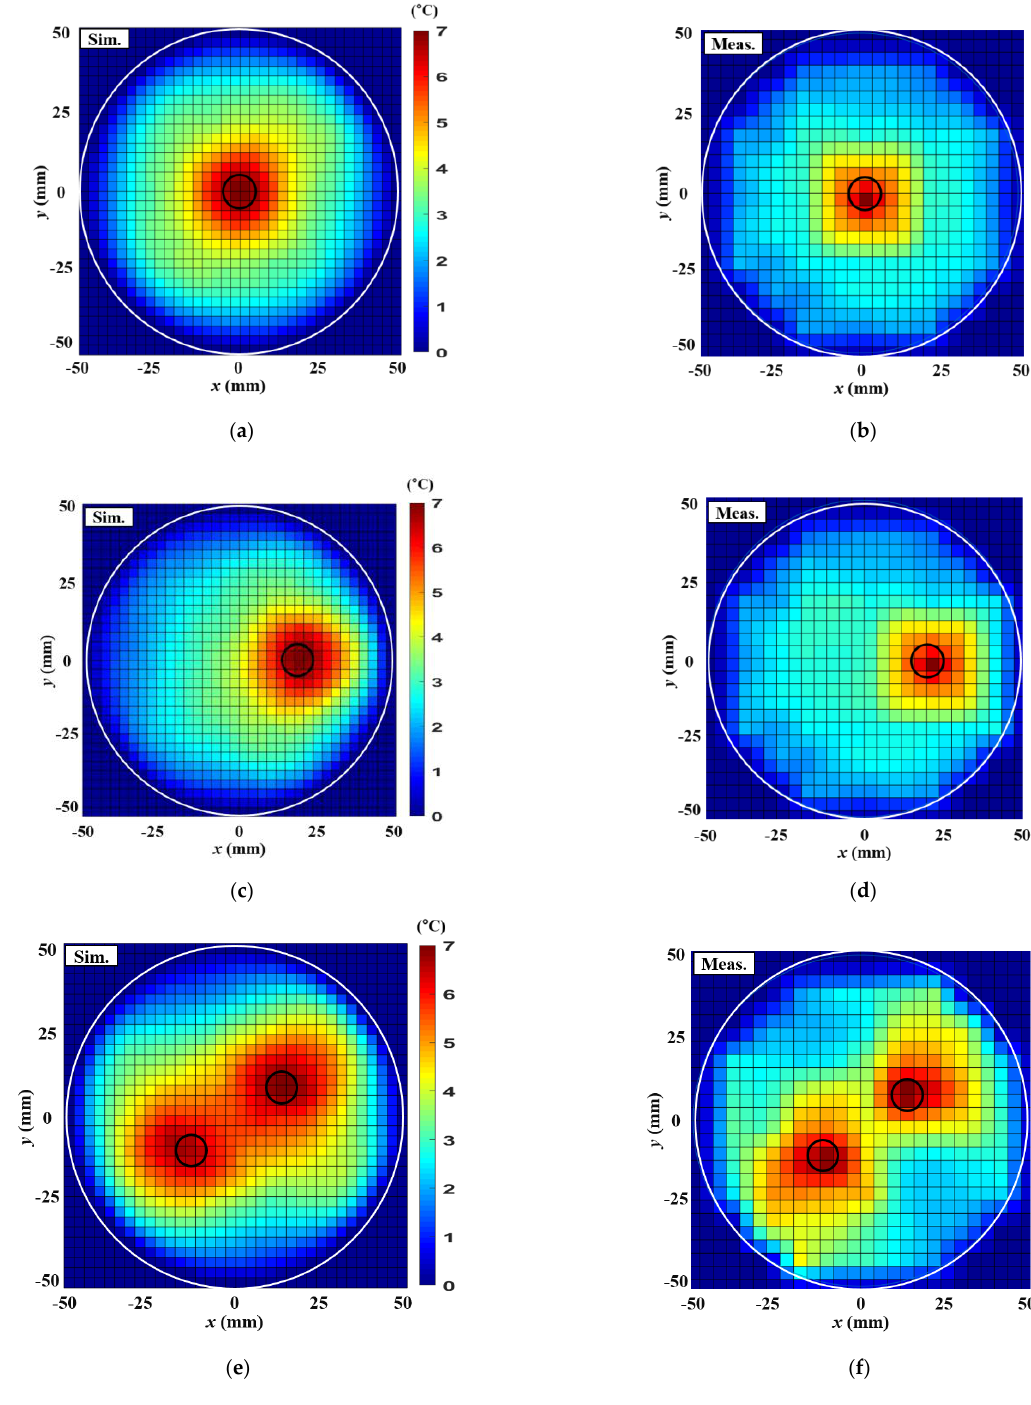
( c ) Figure 13. T he transient temperature distribution at the tumor center: ( a ) single tumor at (0,0) mm, ( b ) single tumor at (20,0) mm, and ( c ) two tumors at (15,10) mm and (−15,−10) mm. Table 5. Comparison of the simulation and measurement results. Parameters Single Tumor at (0,0) mm Single Tumor at (20,0) mm Two Tumors at (15,10) mm, ( − 15, − 10) mm Input RF power (W)